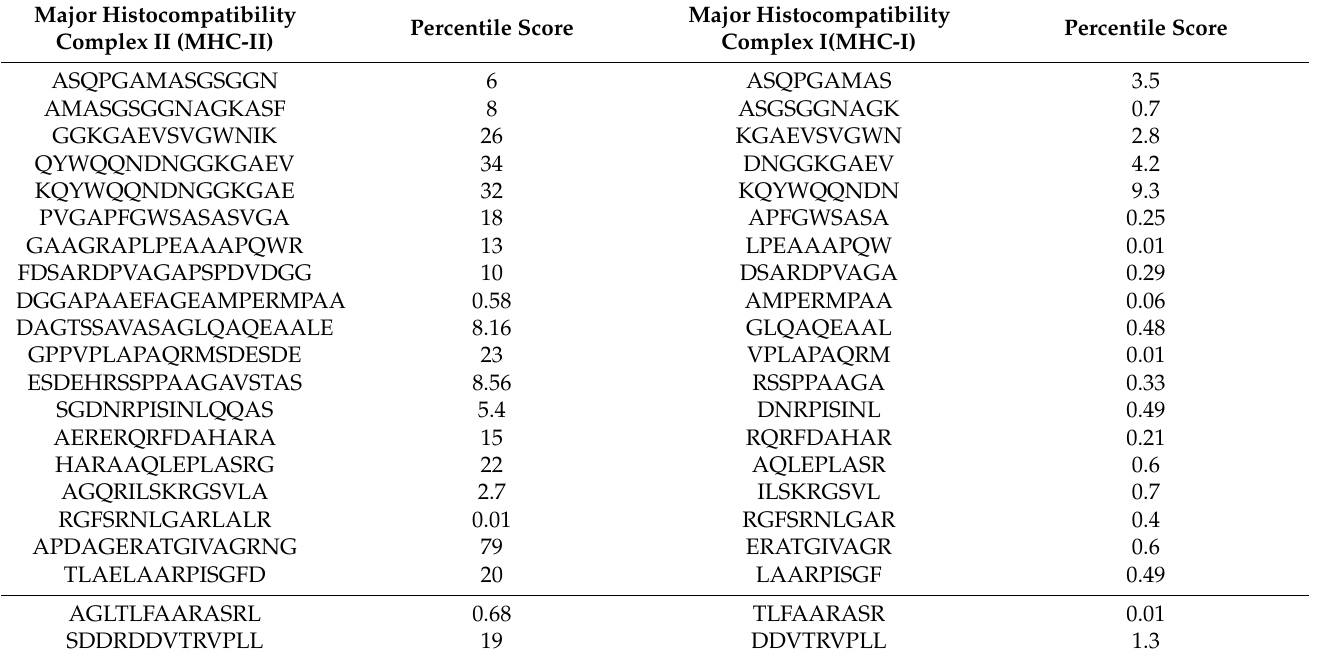
Table 2. T-cells epitopes with lowest percentile